Question: Describe this figure in one sentence.
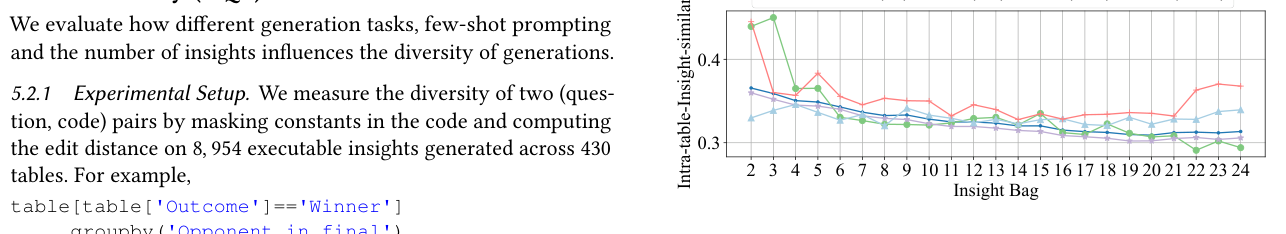
Answer: Evolution of diversity as more insights are gener- ated for all tables and divided by number of columns. T(4- 8) means tables with 4 to 8 columns. For tables with more columns, the model becomes repetitive.